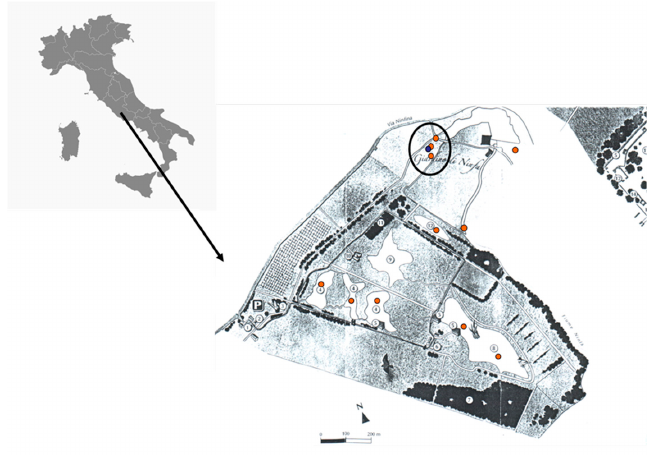
Figure 1. The study area. Orange dots indicate the localities within the Laghi di Ninfa Natural Reserve where Procambarus clarkii was found between 2008 and 2013, the blue dot indicates the only population of Cherax destructor present in the area up until 2012. Numbers indicate the different ponds of the wetland area of Pantanello. The circle indicates the area of cultivation